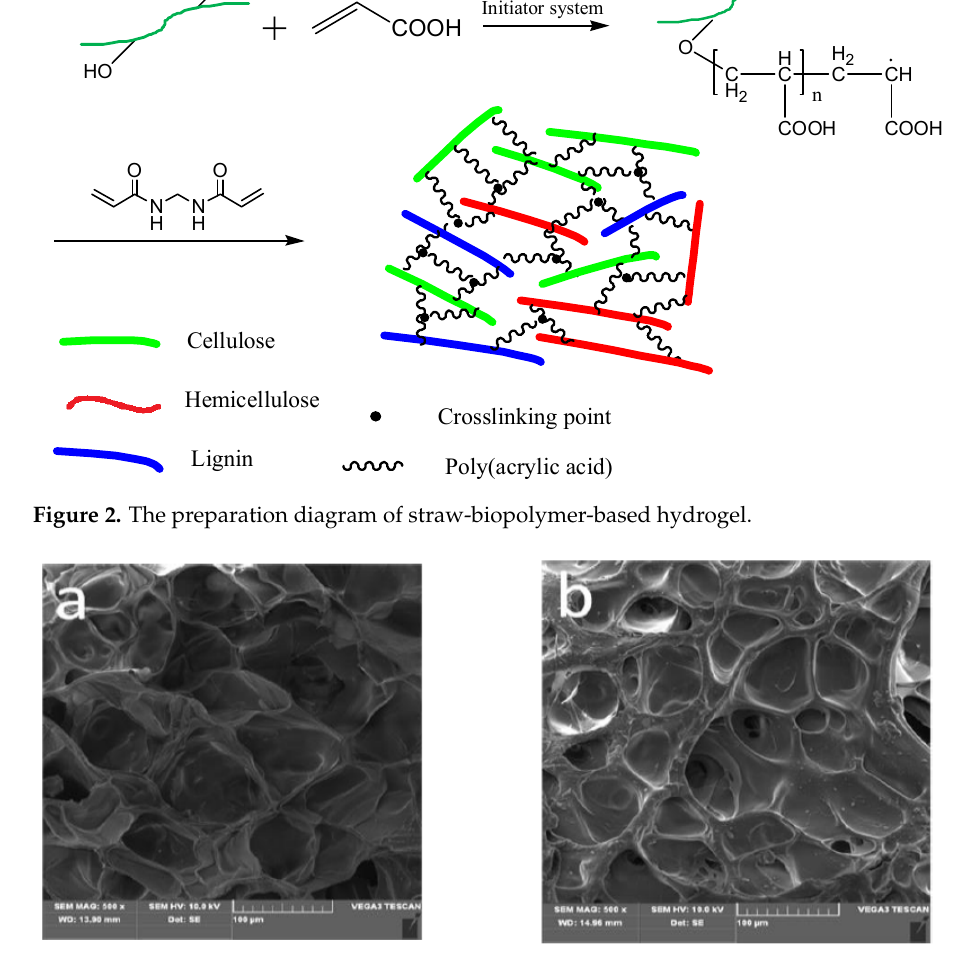
Figure 3. SEM images of the prepared hydrogel: ( a ) before adsorption; ( b ) after adsorption.